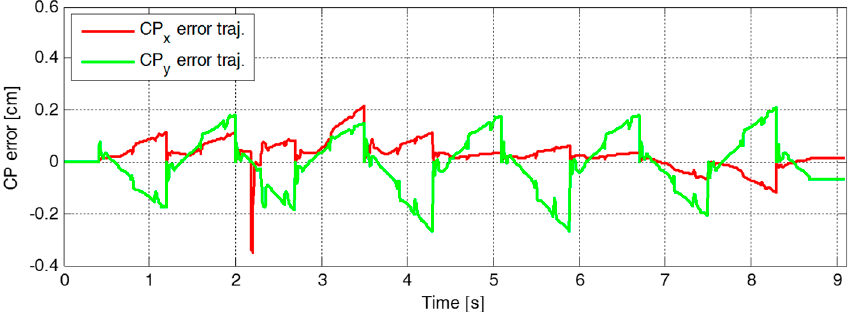
Figure 10. Error trajectories between the reference and the measured CPs, ξ ref and ξ c , in the first simulation.